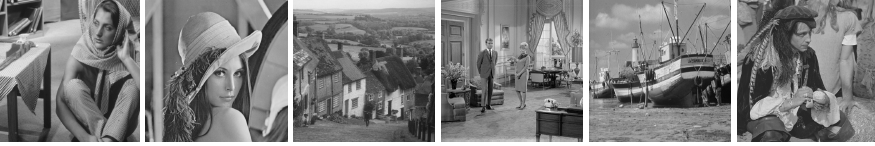
Figure 4. The test images ‘Barbara’, ‘Lena’, ‘Hill’, ‘Couple’, ‘Boat’, and